Question: In a single sentence, describe what this figure presents.
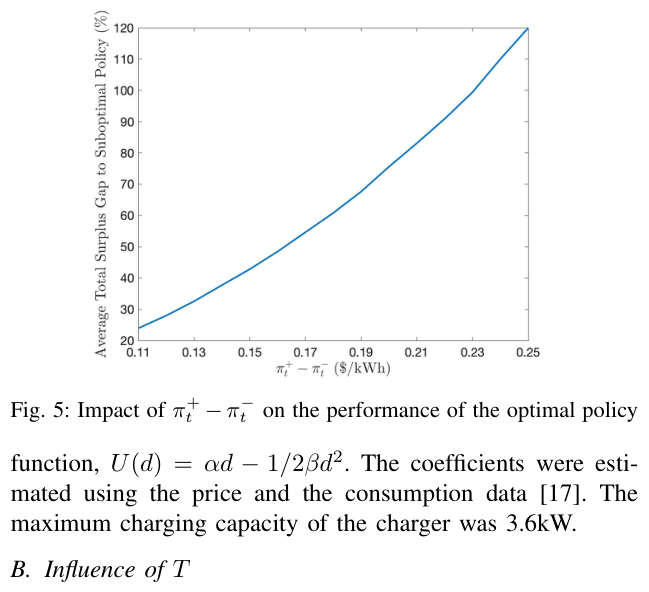
Answer: Impact of T on the performance